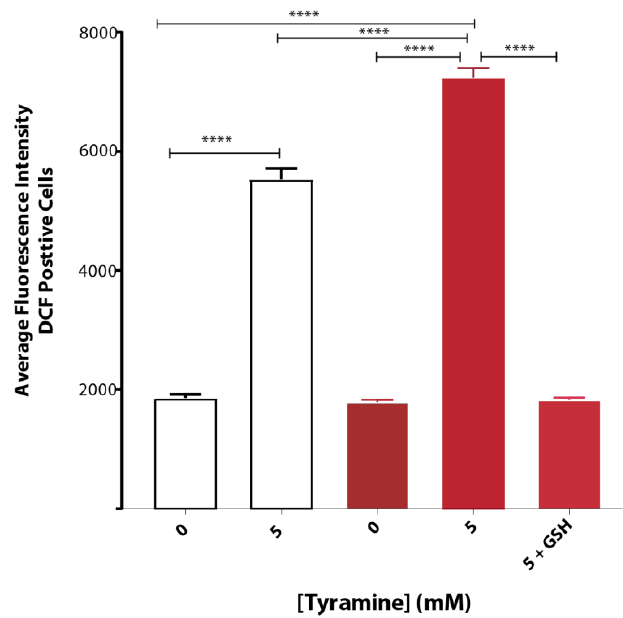
Figure 3. Oxidative stress of S. cerevisiae BY4743 (pYEX.BX) (white bar) and BY4743 ( pYEX.Aβ ) (red bar) transformants using H 2 DCFDA staining in presence of tyramine and rescue with 5 mM reduced glutathione. Values are from triplicates, and values significantly different in one-way ANOVA are indicated by asterisks ( **** p < 0.0001). Biomedicines 2020 , 8 , x FOR PEER REVIEW